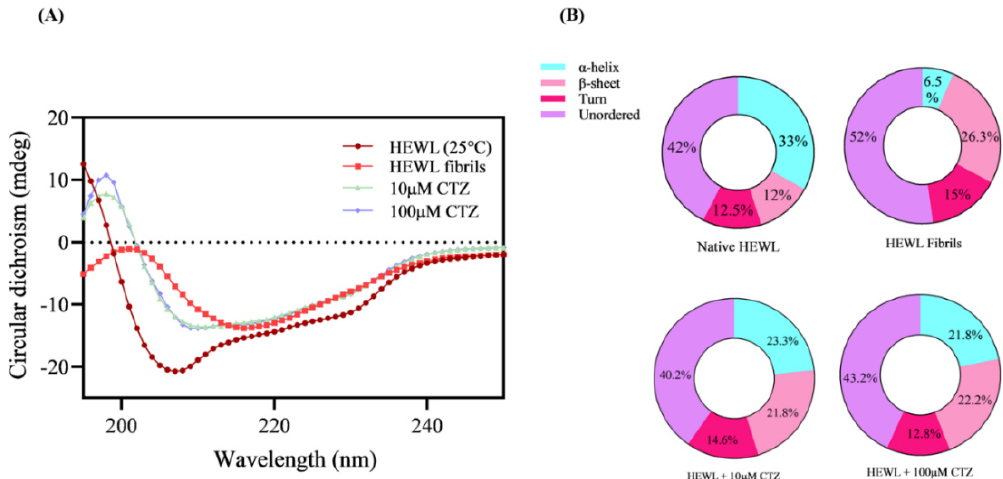
Figure 6. Change in secondary structure in presence of CTZ. ( A ) Far-UV CD spectra of native 10 µM HEWL at 25 °C and HEWL incubated for 10 hrs at 55 ºC with/without 10 µM and 100 µM CTZ. ( B ) Secondary structural contents of HEWL incubated with/without 10 µM and 100 µM CTZ as calculated from BeStSel.